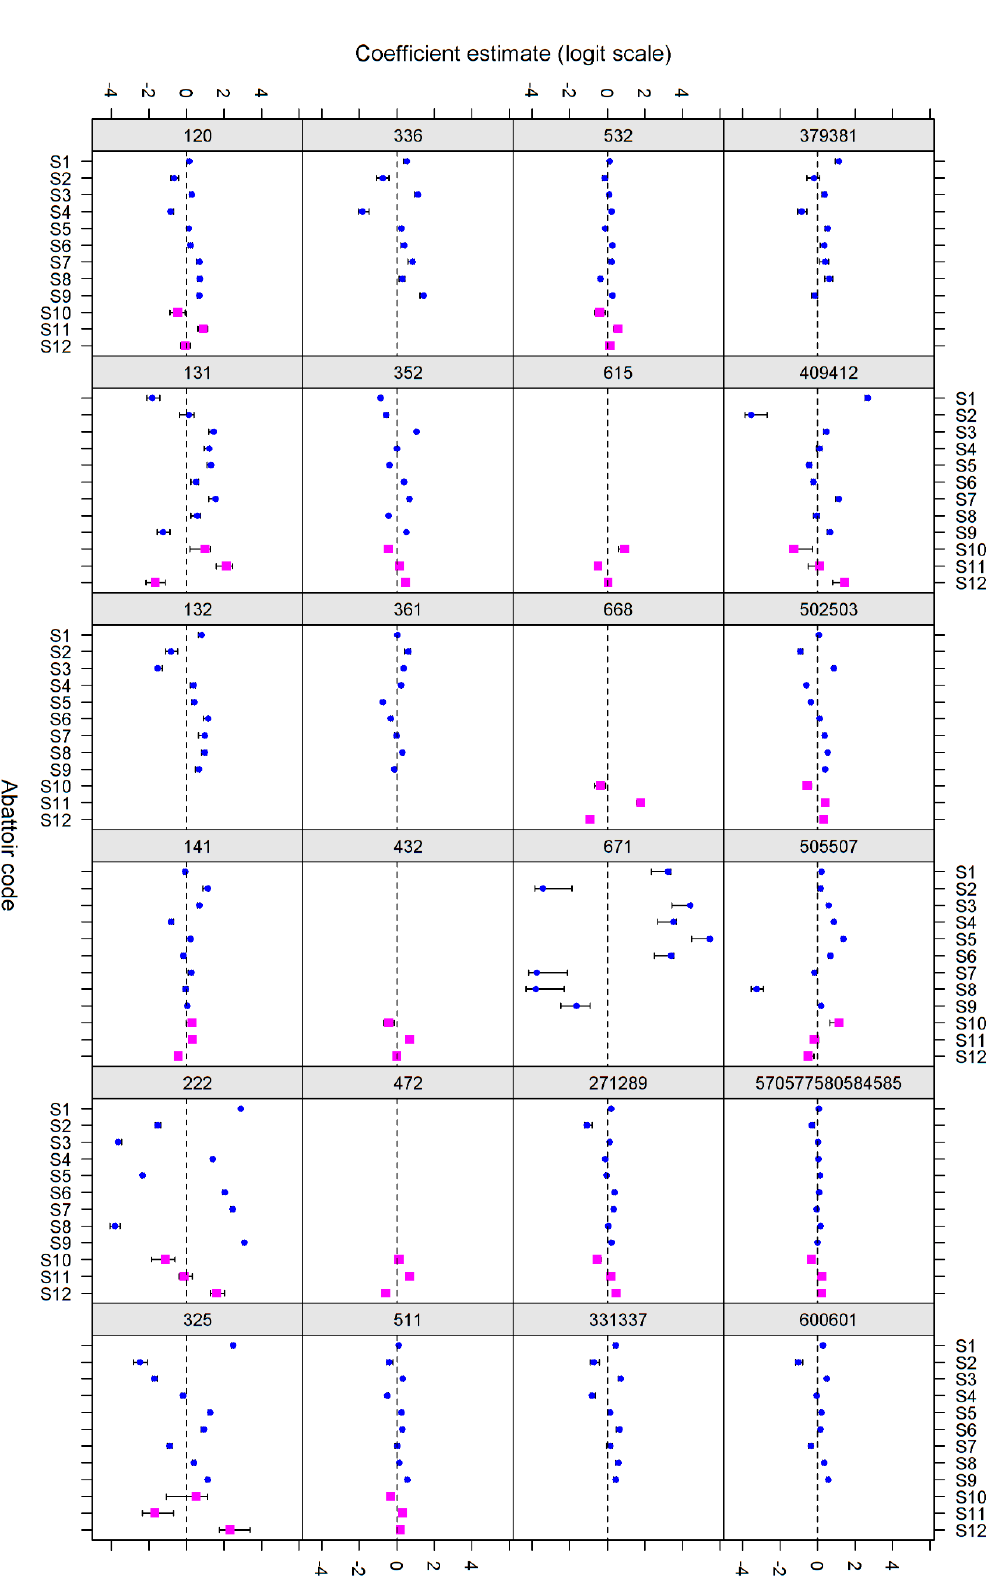
Figure 1. Individual estimates for the variance partition effect of each abattoir (95% confidence intervals shown as bars) for each code in pigs (S1–S9, blue) and sows (S10–S12, pink).